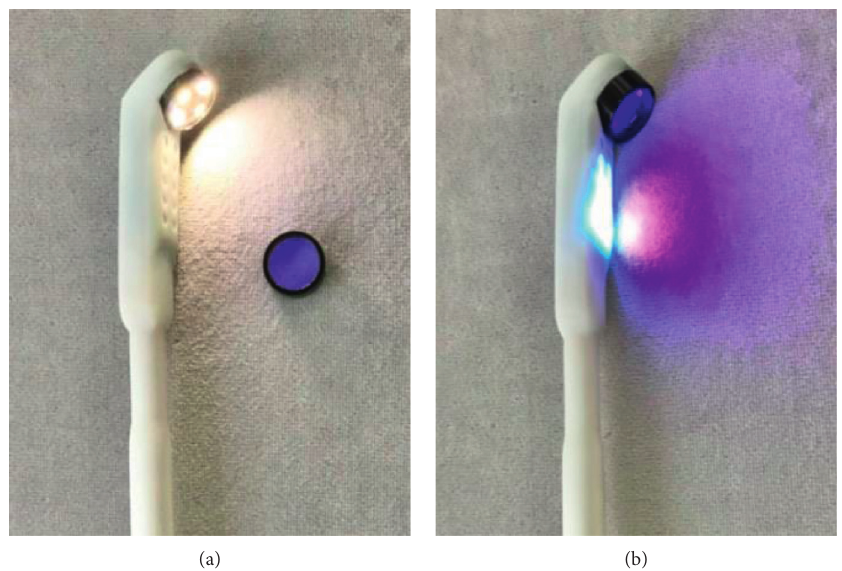
Figure 4: Application of the devices in (a) LED white light mode and (b) autofluorescent